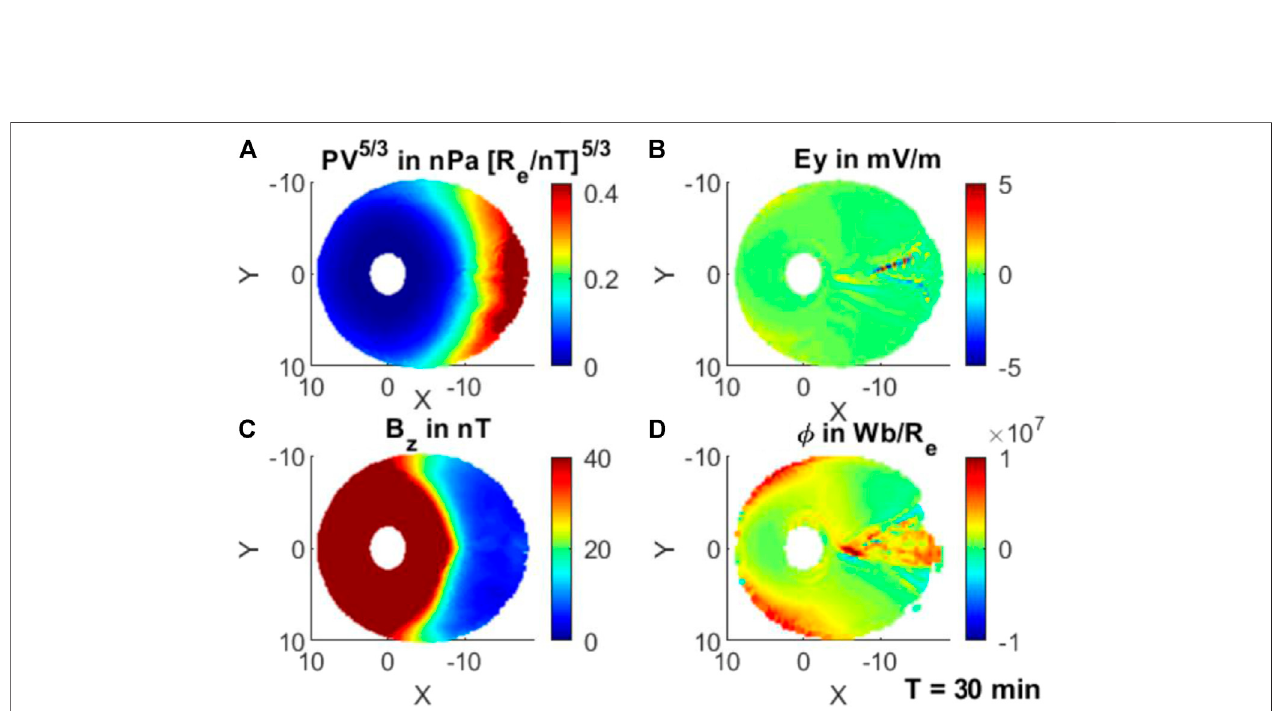
FIGURE 3 | Single bubble run at T (cid:1) 30 min; (A) entropy parameter PV 5/3 in nPa [R e /nT] 5/3 ; (B) dawn-to-dusk component of the electric fi eld E y in mV/m; (C) B Z in nT; and (D) cumulative magnetic fl ux transport ϕ in Wb/R e .